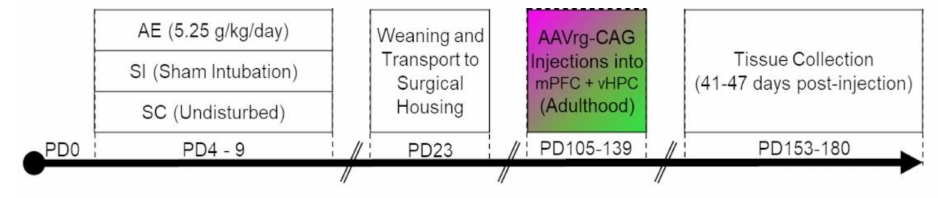
Figure 1. Experimental timeline for the current study.